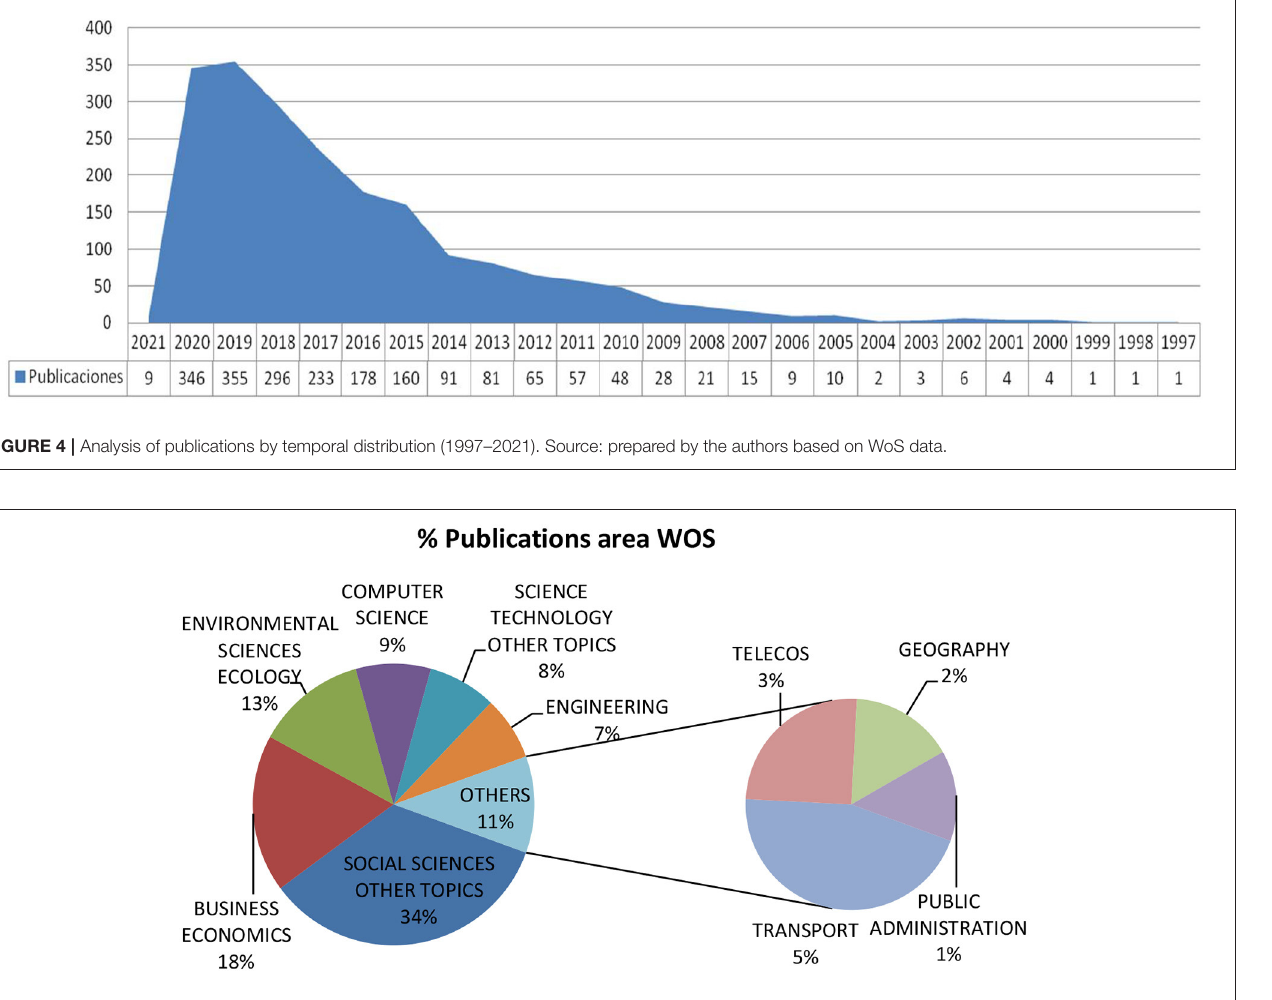
FIGURE 5 | Analysis of publications by WoS research area. Source: prepared by the authors based on WoS